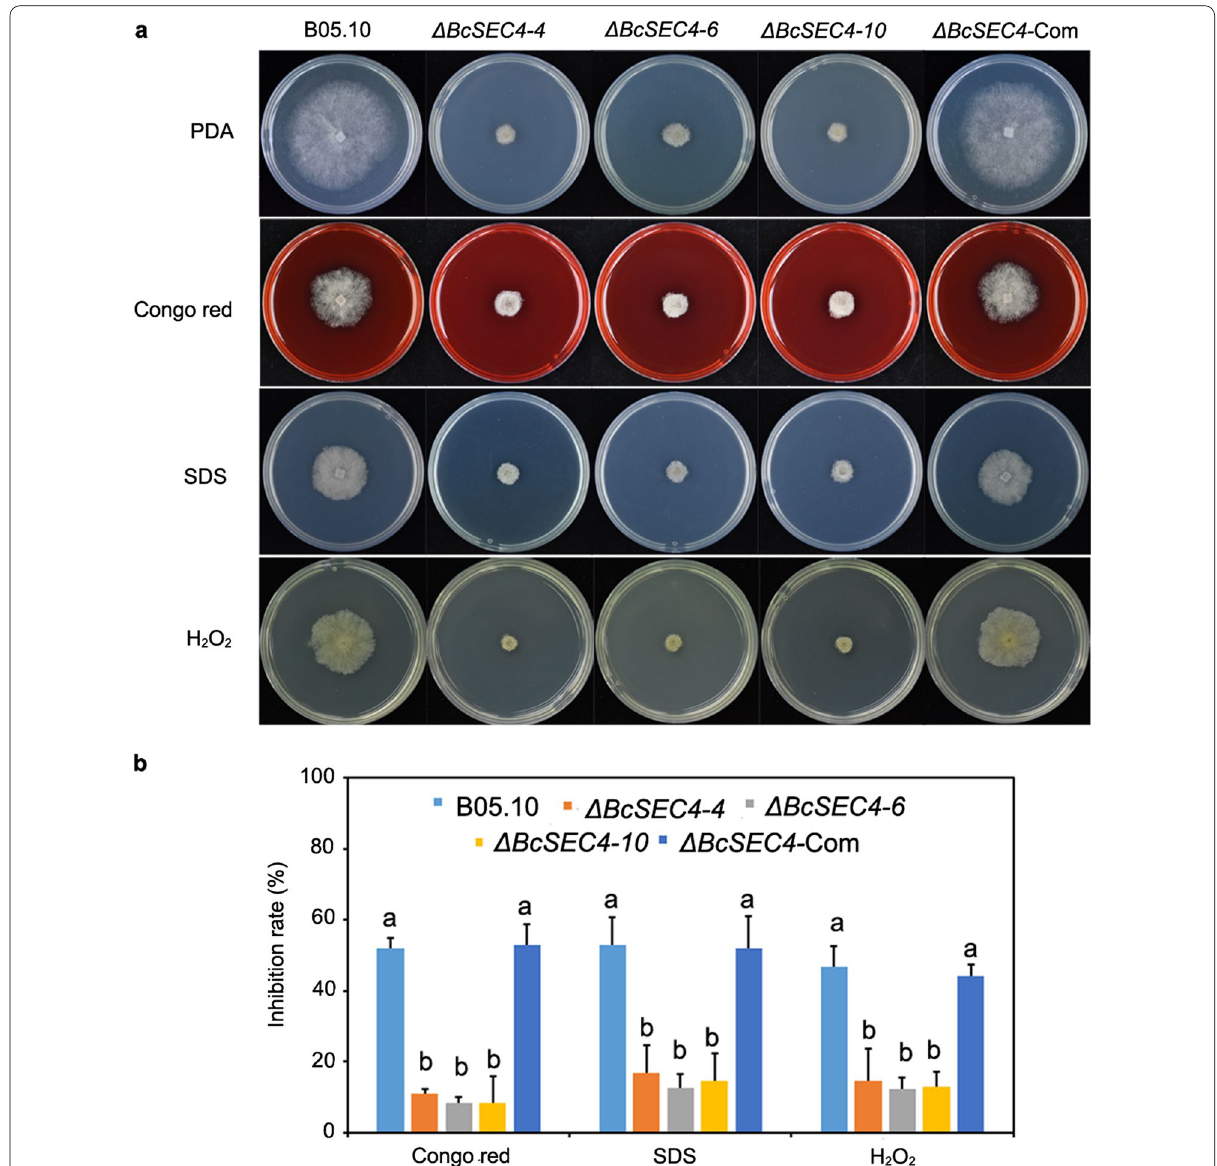
Fig. 2 BcSec4 plays important roles in response to various stressors in B. cinerea . a The wild‑type strain B05.10, the ΔBcSEC4 mutants, and complemented strains grown on PDA medium with or without stress inducers as indicated for 3 days at 25 °C. b Inhibition rates of various stressors on vegetative growth of the indicated strains. The growth inhibition rate (%) [(colony diameter without stressor colony diameter with stressor)/ = − (colony diameter without stressor)] 100. Three replications were performed with similar results. Different letters indicate statistically significant × differences ( P <